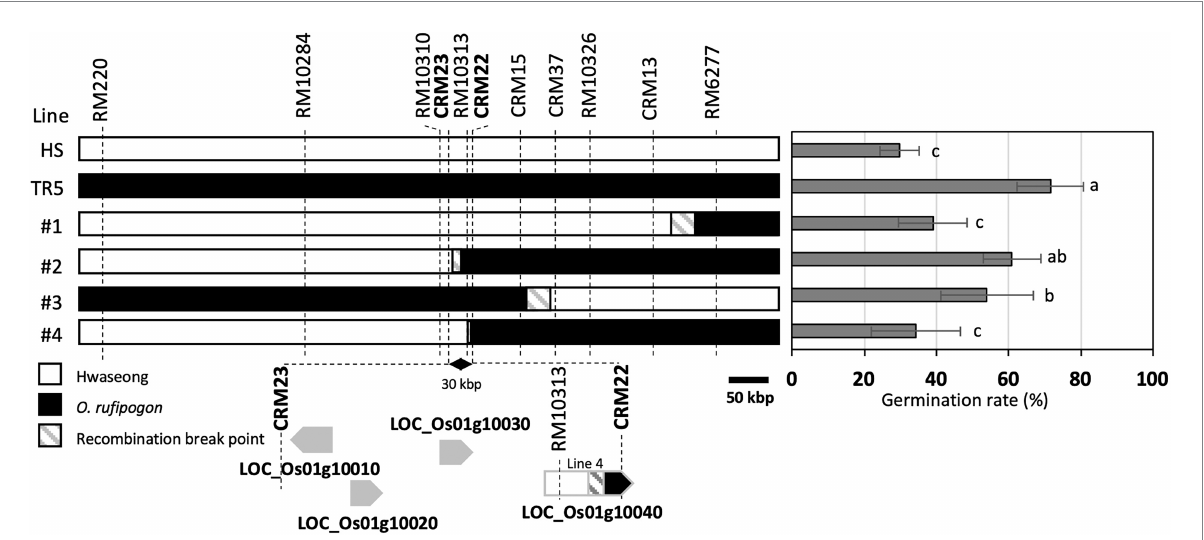
FIGURE 2 Substitution mapping of qLTG1 . Germination percentage was measured at 7 days after incubation. Error bars indicate the SD of the mean. Different letters to the right of the bar graph indicate significant differences at p < 0.05, based on Tukey’s test.